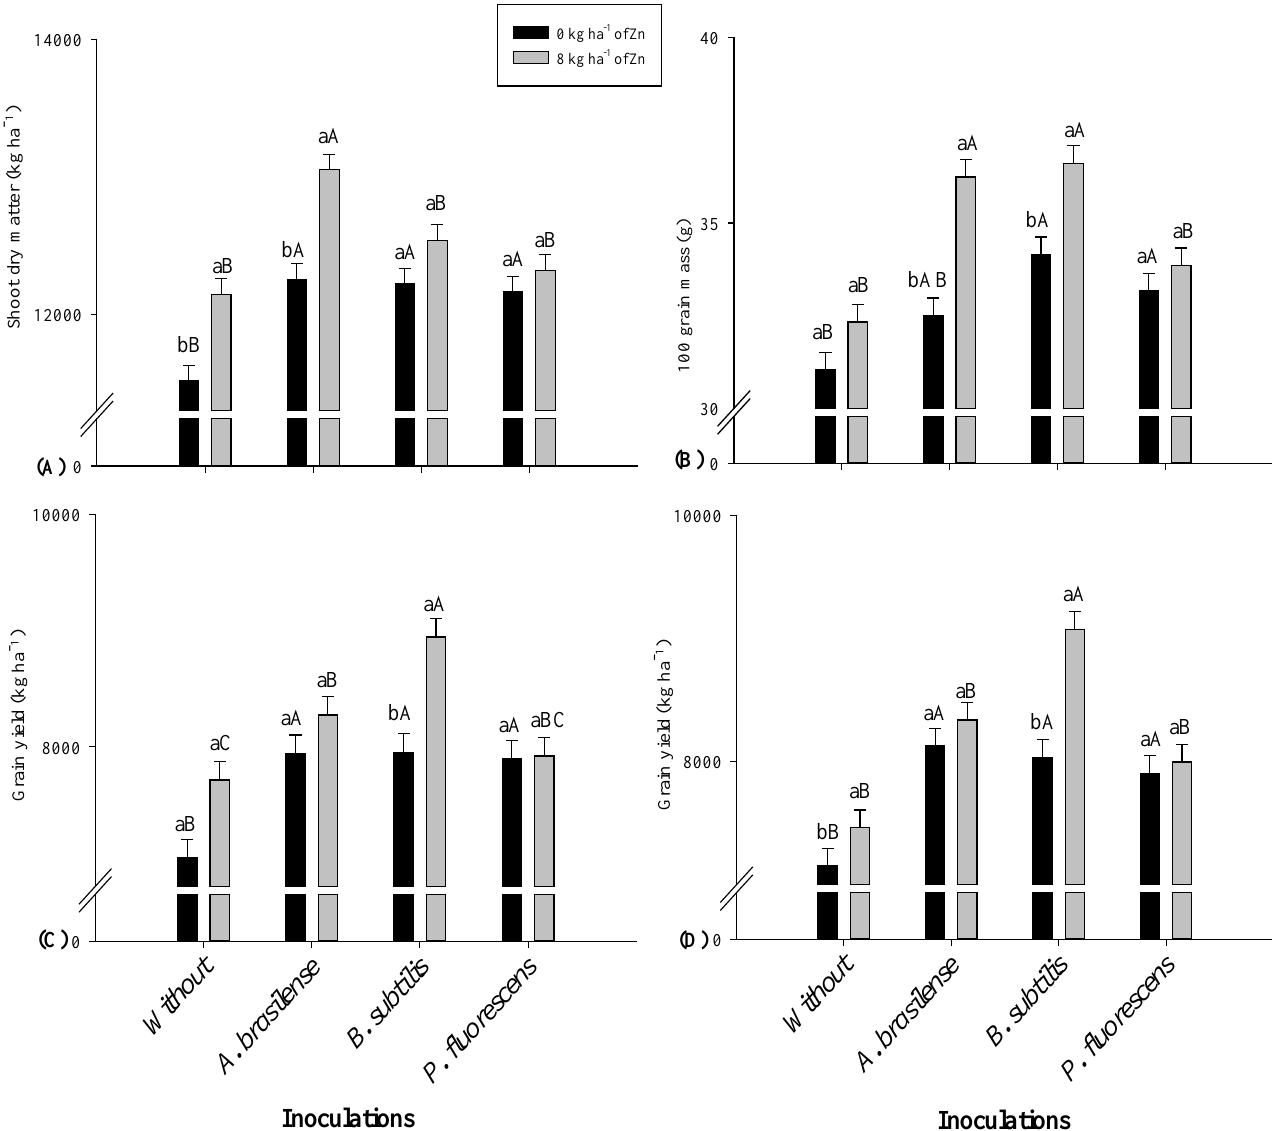
Figure 1. Maize shoot dry matter ( A ) and 100 grains mass ( B ) in 2020–2021 respectively, and grain yield in 2019–2020 ( C ) and 2020–2021 ( D ) as function of residual Zn doses and diazotrophic bacteria. Without = control (no inoculation). The uppercase letters are used for inoculation interactions within each level of soil applied residual Zn whereas lowercase letters are used for the interactions of Zn doses (presence and absence) within each inoculation treatment. The identical alphabetic letters do not differ from each other by Tukey test ( p < 0.05) for Zn doses and inoculations in 2019–2020 and 2020–2021. Error bars indicate standard error of the mean ( n = 4 replications).